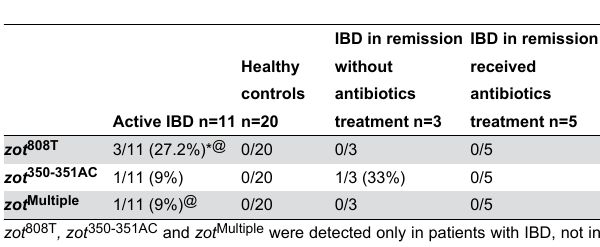
Table 4. Nucleotide polymorphisms of Group I, Group II and Group IV C. concisus zot .